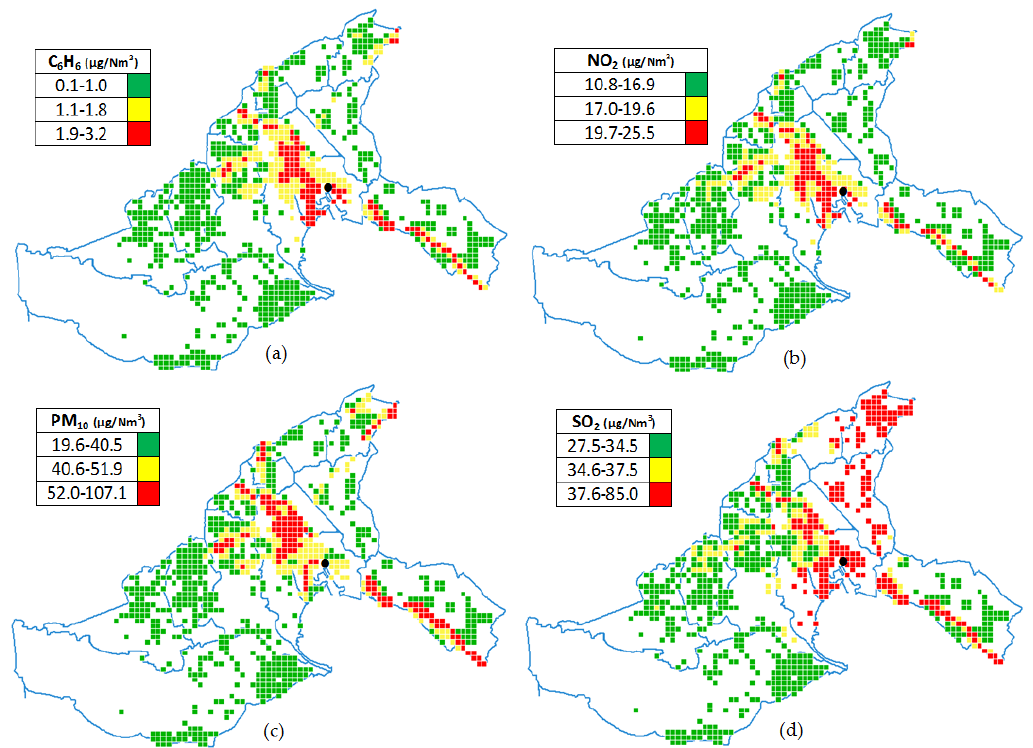
Figure 1. Mathematical modeling of residential exposure to air pollutant in study area, stratified to tertile of exposure: ( a ) Benzene exposure; ( b ) Nitrogen dioxide exposure; ( c ) Particular matter exposure; ( d ) Sulfur dioxide exposure. 400 × 400 m cells correspond to area populated by one or more inhabitants in 1995–2009 period. The blue line corresponds to the boundaries of individual municipalities. The black point corresponds to the location of the thermal power plant.